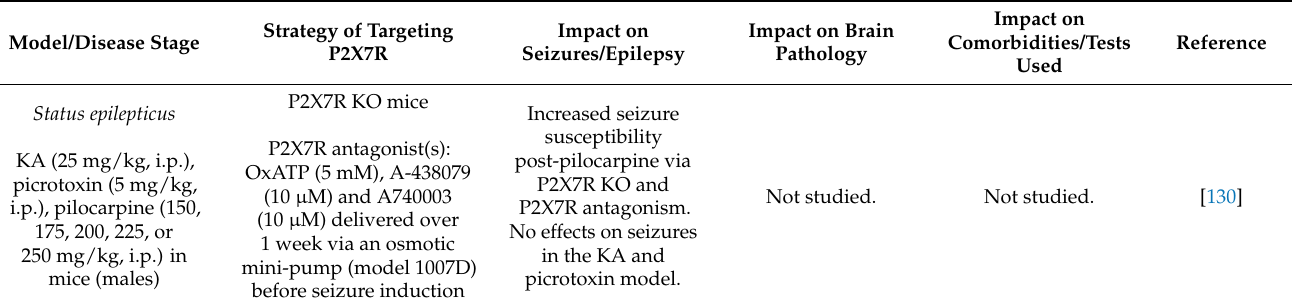
Table 1. Selected examples of in vivo studies investigating the impact of P2X7R signalling on seizures and epilepsy-related